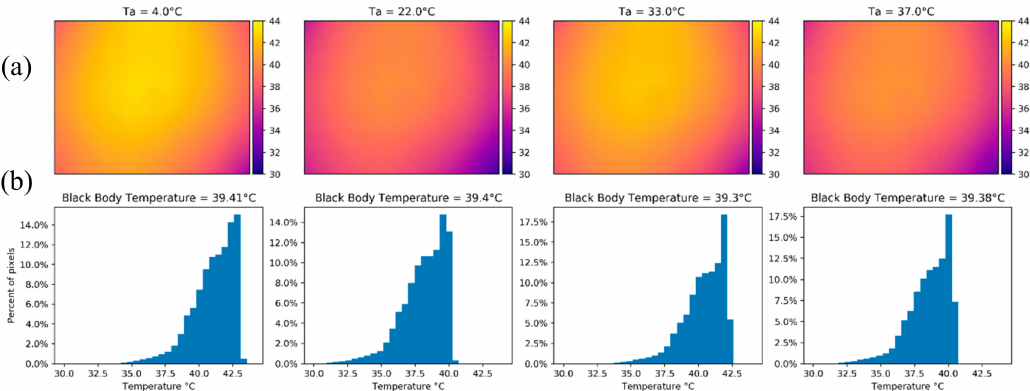
Figure 10. ( a ) Thermal images from the TeAx 640 with the β 0 coe ffi cient set to zero with a similar black body temperature across all ambient temperatures. The vignette e ff ect was present and had the same shape as the uncalibrated images. ( b ) The corresponding histograms are similar to the uncalibrated images with a dispersion of 1.553 ◦ C from the mean values (40.78, 37.88, 40.12, 38.33 ◦ C